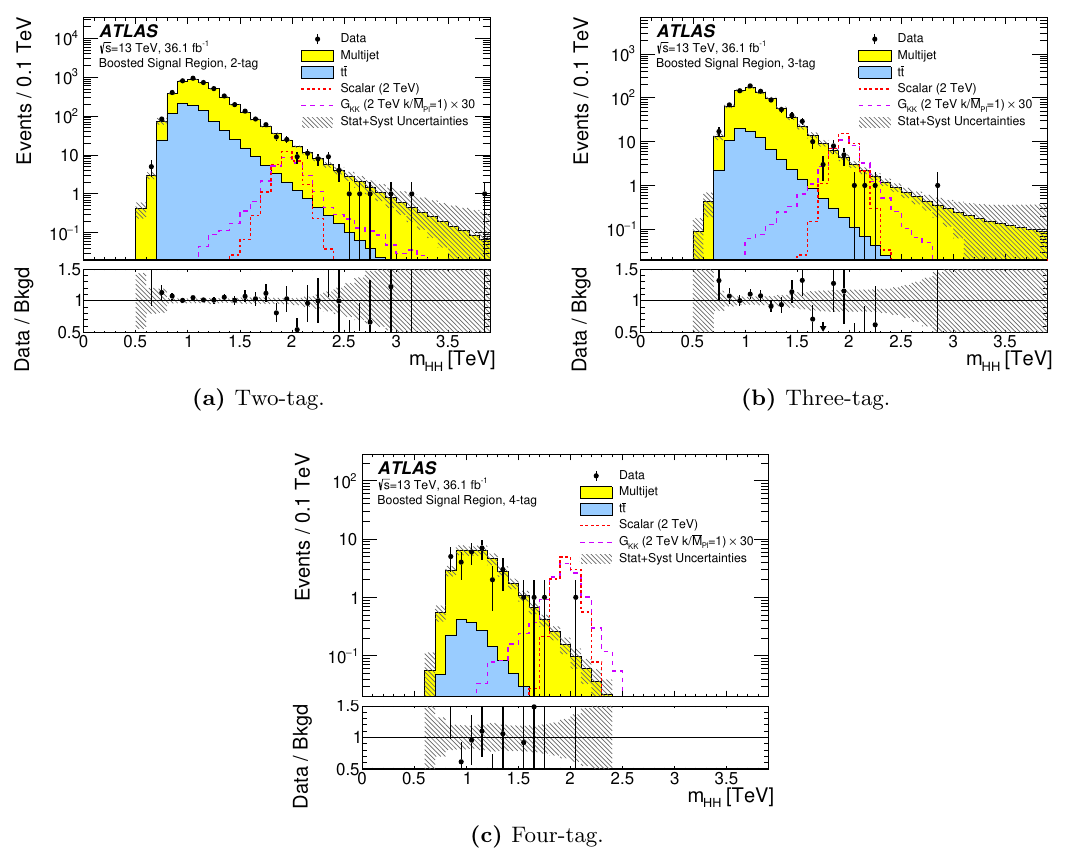
Figure 8. Distributions of m 2J in the signal regions of the boosted analysis for (a) the two-tag sample, (b) the three-tag sample, and (c) the four-tag sample, compared to the predicted back- grounds. The data-to-background ratio (bottom panels) shows also the combination of statistical and systematic uncertainties as the grey hatched band. The expected signal for a 2 TeV G KK reso- nance with k=M Pl = 1 and a scalar with the same mass is also shown. The scalar has an arbitrary cross section times branching ratio of 12